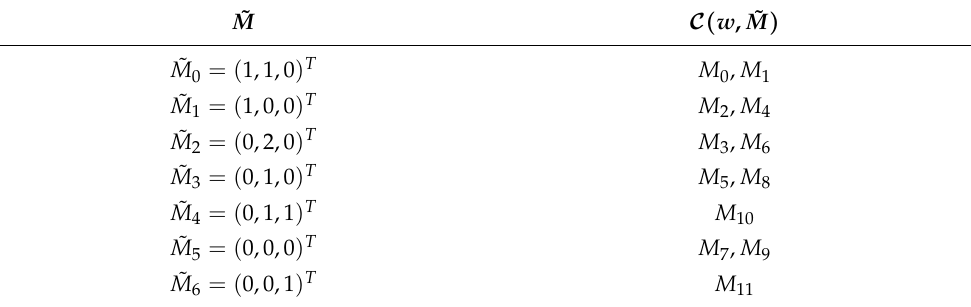
Figure 6. An observer of the unbounded net system. Table 2. Set of markings with respect to ˜ M